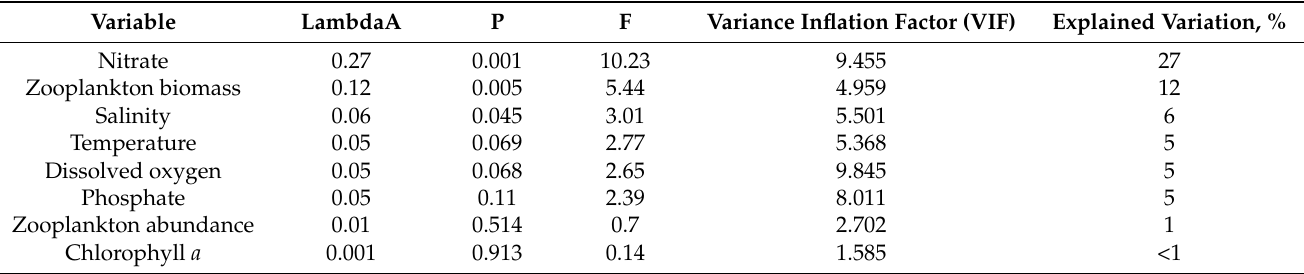
Table 3. Results of Monte Carlo permutation test in RDA: list of environmental variables affected microbial plankton in the northeastern Barents Sea, in autumn